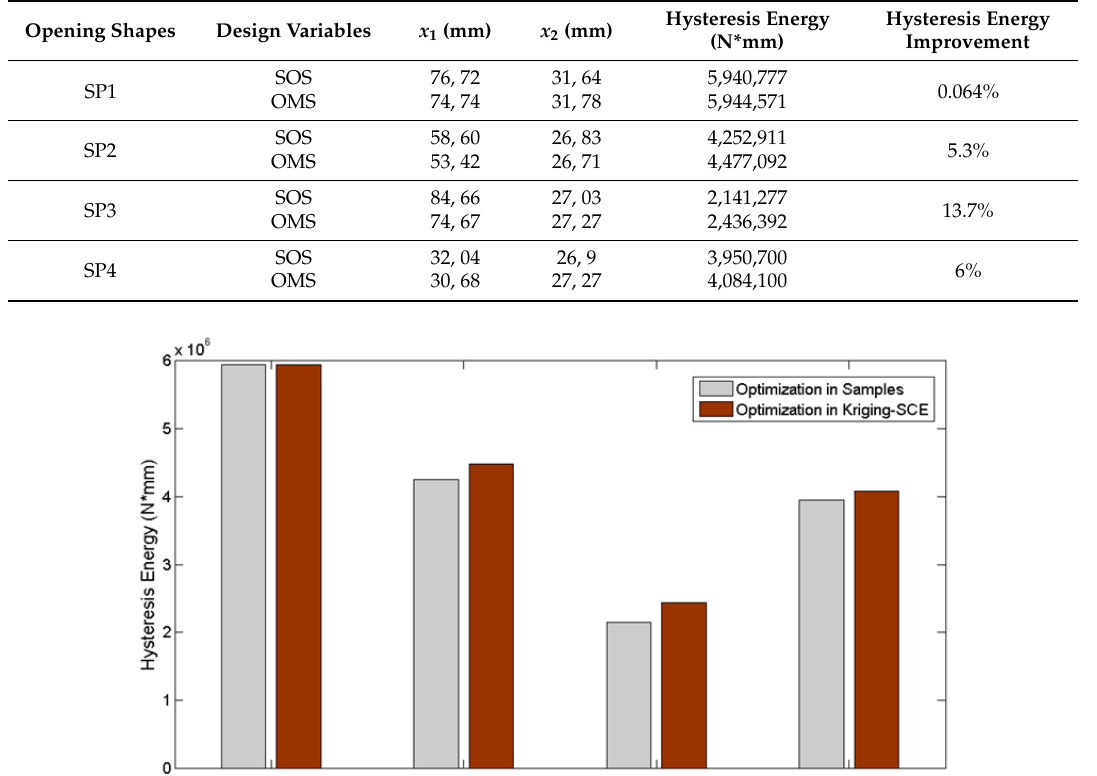
Table 1. Optimization results for sample optimal solution (SOS) and optimization model solution (OMS).